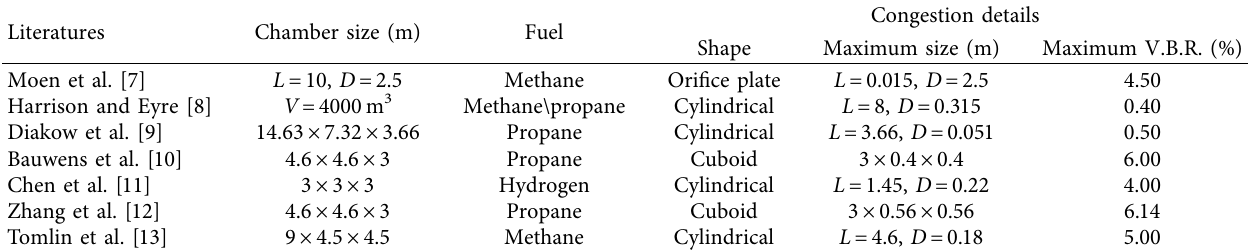
Table 1: Details of congestion research on large-scale vented